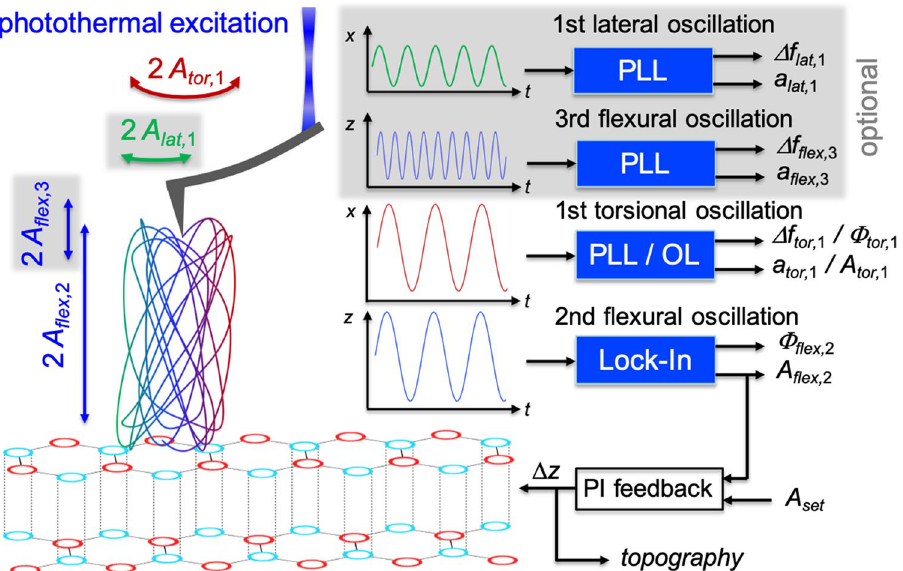
Figure 1. Schematic illustration depicting the setup of the AMFlex2-OLTor1-FMLat1-FMFlex3 mode. Topographical feedback is driven at the coupled resonance frequency of the second flexural and the first torsional eigenmode using the flexural component for amplitude modulation. The first-torsional-eigenmode amplitude and phase are recorded at the same frequency in an open-loop configuration. Optionally, the setup can be expanded by one or two phase-locked loops, tracking the phase at resonance of the first lateral and/or the third flexural eigenmode which allowed us to quantify forces in in-plane and/or out-of-plane direction from the respective frequency-shift data. Dissipative tip-sample interactions can be analyzed from the drive amplitudes ( a lat, 1 , a flex ,3 ) and the respective phase shifts ( Φ flex ,2 , Φ tor, 1 ). The cantilever dimension was substantially reduced for